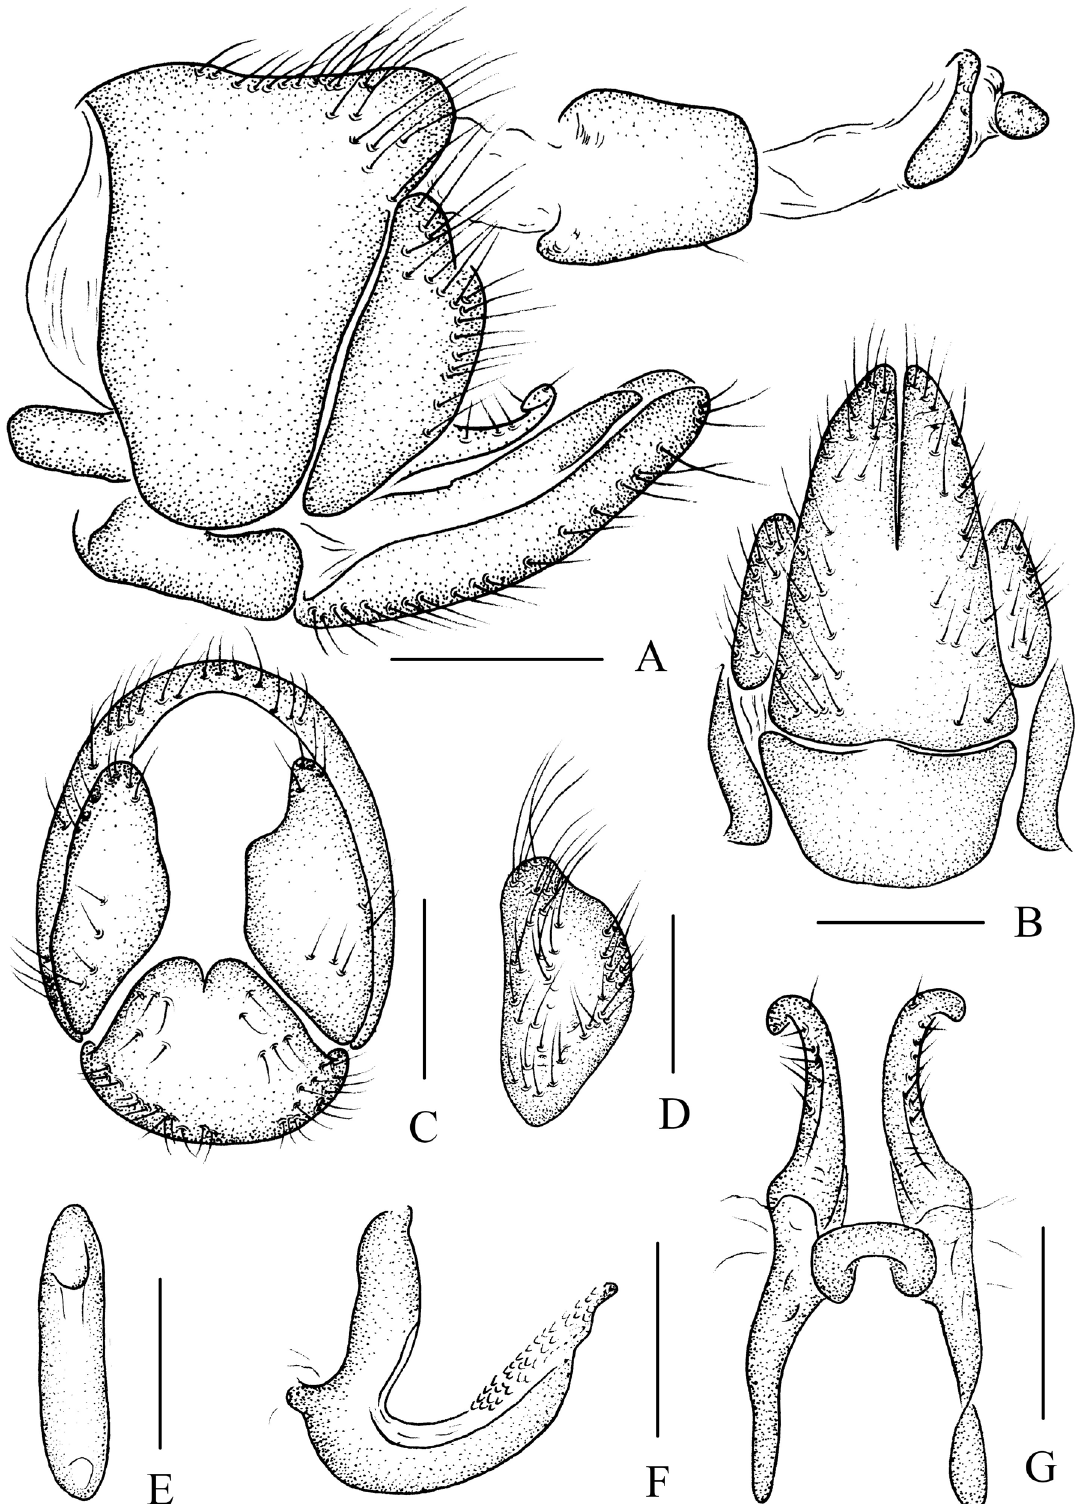
Fig. 6. Machaerotypus nodulus Li & Chen sp. nov., holotype, ♂ (IEGU). A–C . Genitalia in lateral, ventral and posterior view. D . Lateral plate. E–F . Aedeagus in posterior and lateral view. G . Style, dorsal view. Scale bars = 0.2